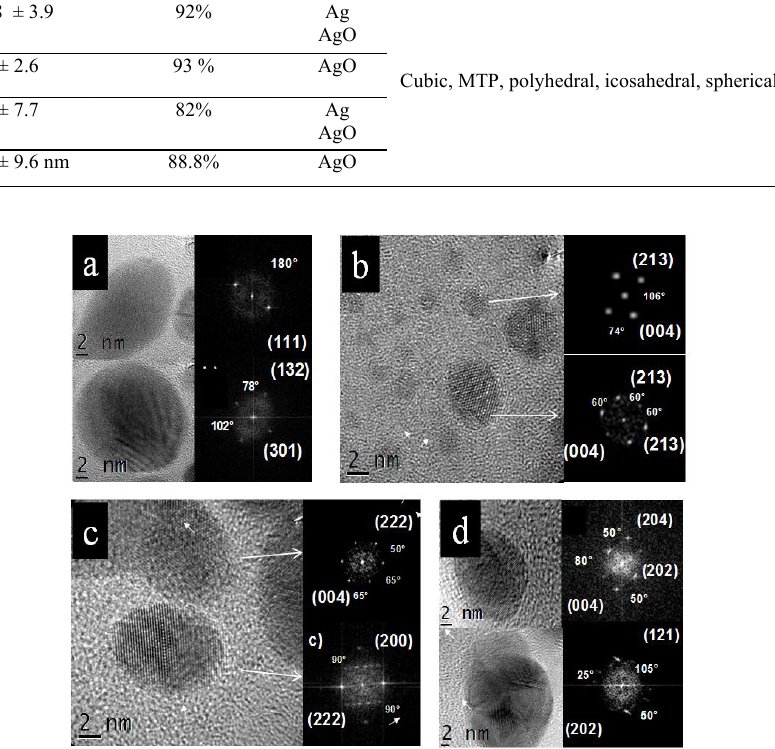
Fig. 6. Bright Field HRTEM images of AgNPs produced for the different pH